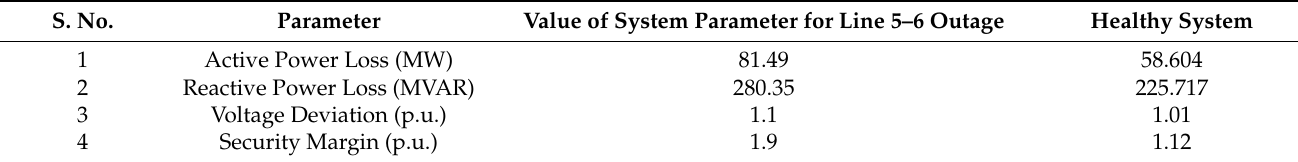
Table 5. Values of system parameters for line 5–6